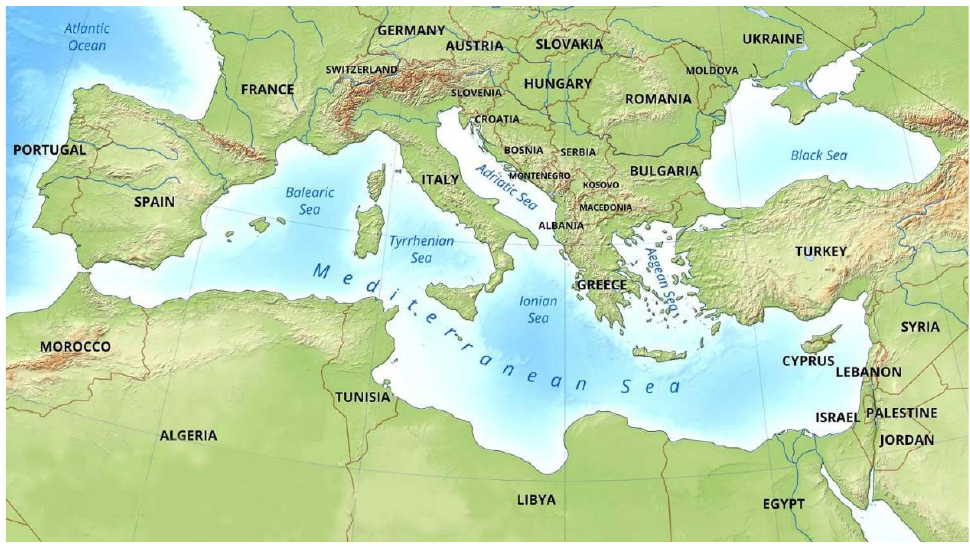
Figure 1. Mediterranean countries. Source: https://www.freeworldmaps.net/europe/mediterra- nean/physical.html (accessed on 9 September 2022).